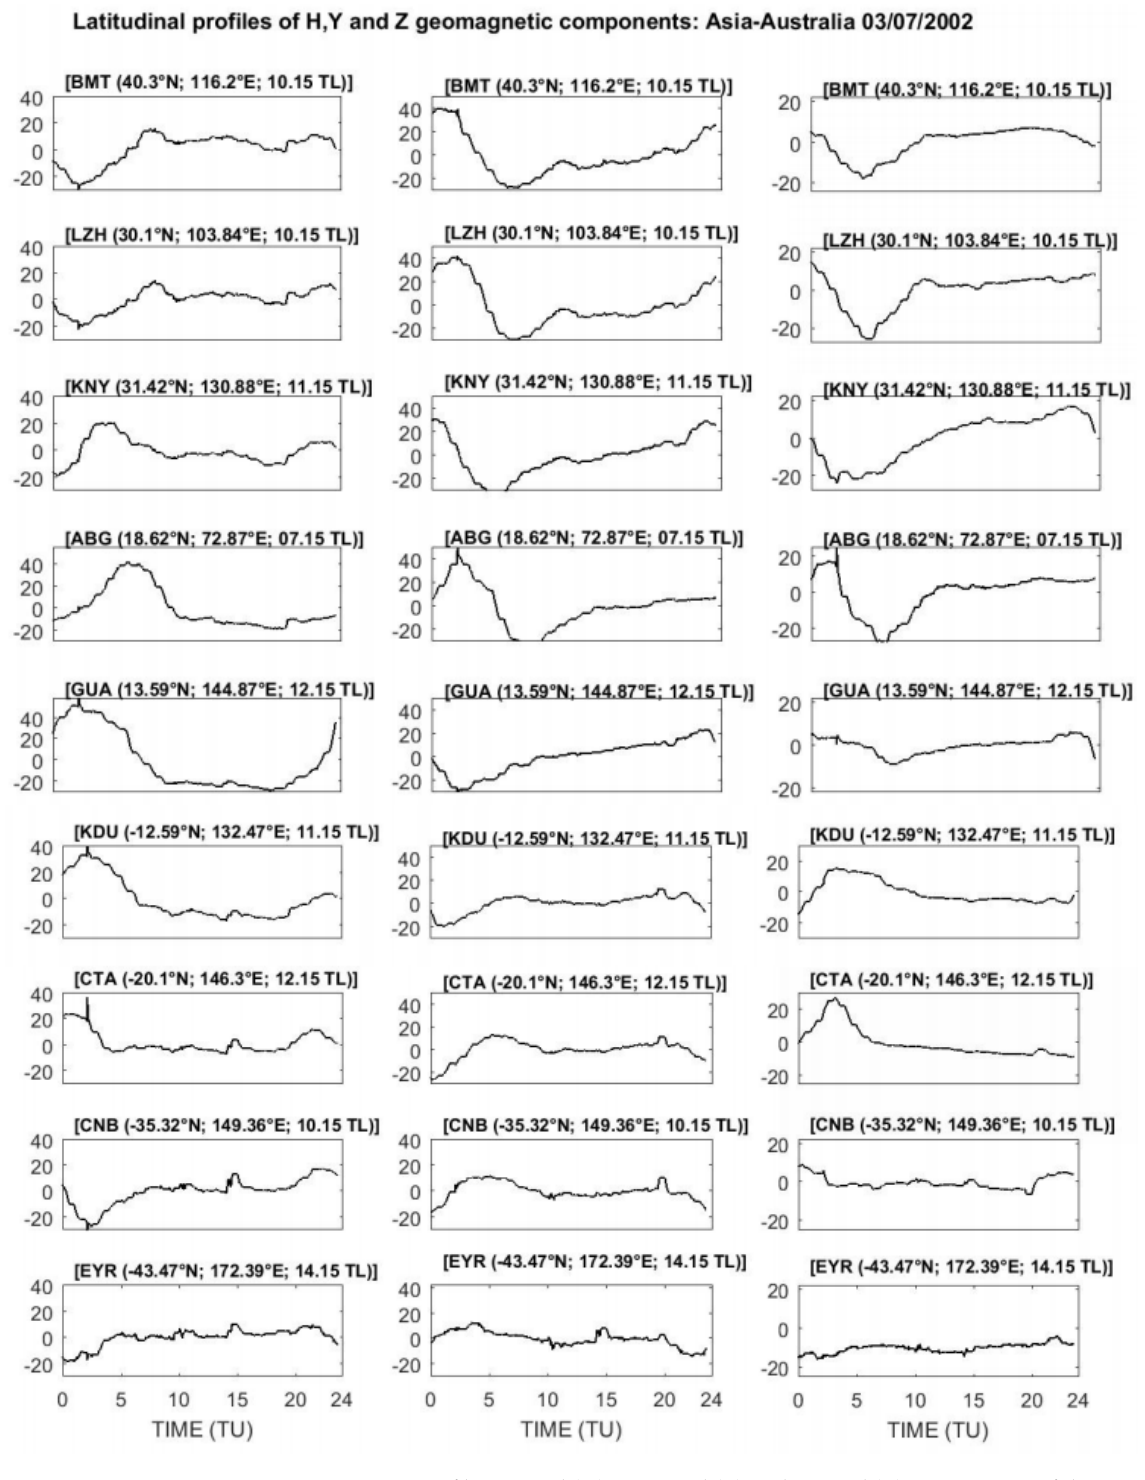
Figure 9. Variation of horizontal (H), eastward (Y) and vertical (Z) components of the geomagnetic field during the X1.5 solar flare of 3 July 2002.